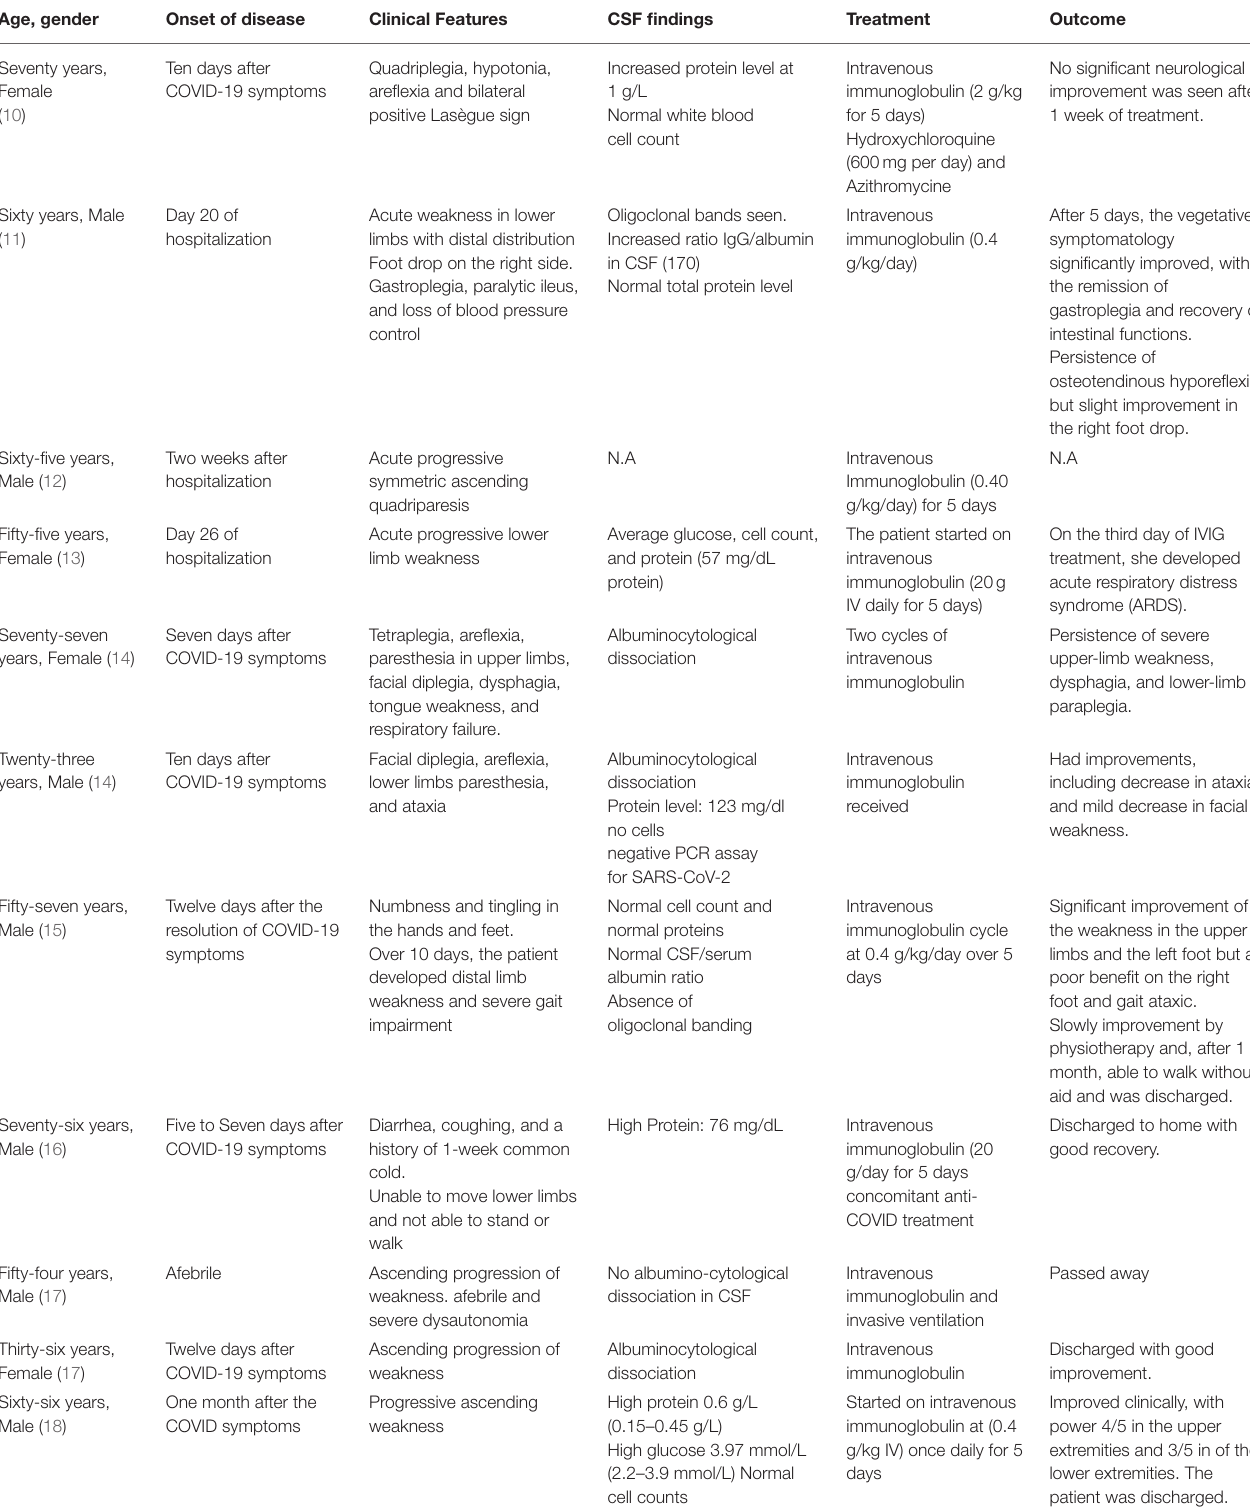
TABLE 3 | Review of the literature for AMSAN-GBS associated with COVID-19. Age,